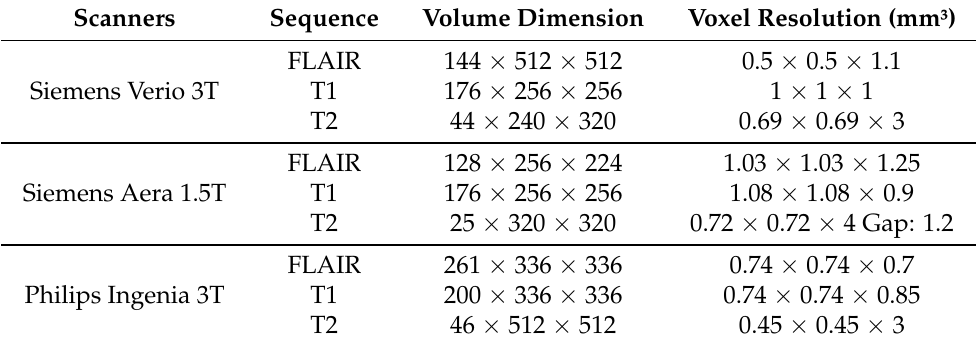
Figure 1. Shown are images of the same patient’s brain in the UMCL dataset [25]: ( a ) FLAIR MRI, ( b ) T2-Weighted MRI, ( c ) T1-Weighted MRI, and ( d ) consensus segmentation. For the MSSEG 2016 dataset, three scanners were used to obtain a sagittal 3D FLAIR image, sagittal 3D T1 image, and an axial 2D T2 image. The acquisition details for this dataset are shown in Table 2. Table 2. MSSEG 2016 MRI Acquisition